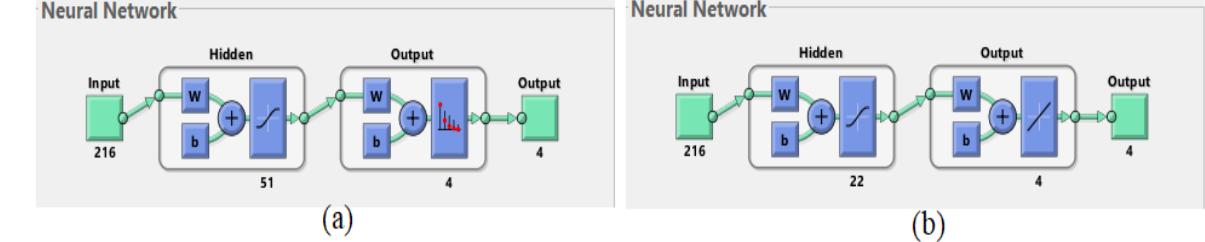
Figure 8. Training of the WBC dataset. ( a ) ANN algorithm and ( b ) FFNN algorithm.